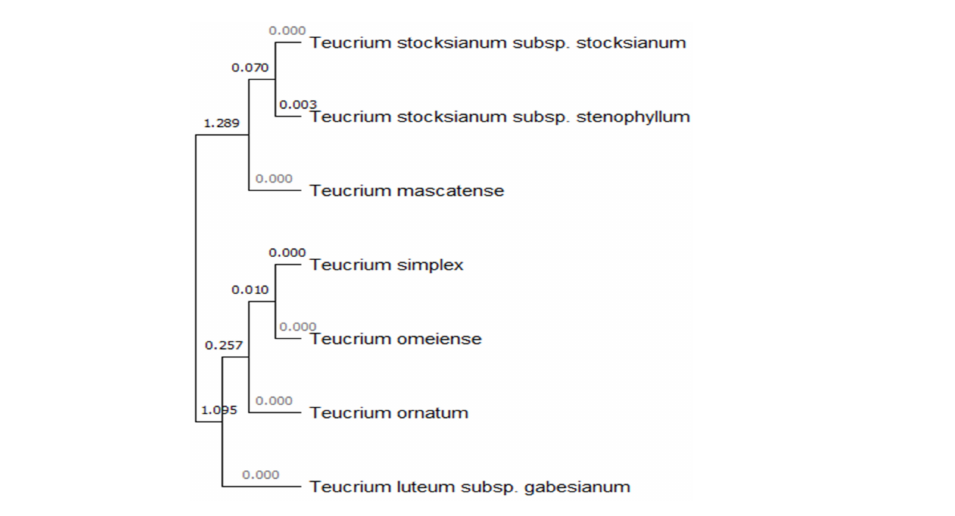
Figure 5. Phylogenetic tree of the genetic distances between Teucrium luteum subsp. gabesianum and six other Teucrium taxa (species and subspecies) with the complete chloroplast DNA genome retrieved from GenBank based on seven molecular marker sequences ( mat K, pet D/ pet B, psb K/ psb I, rbc L, rpo C1, trn H/ psb A and trn L/ trn F) and using the neighbor-joining